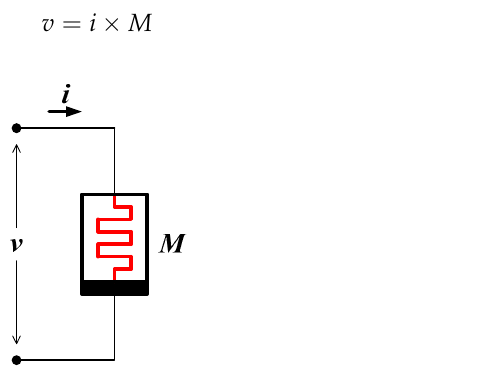
Figure 4. Memristor as an ideal element for a neural synapse where voltage across the memristor is a multiplication between an input current and a memristance.